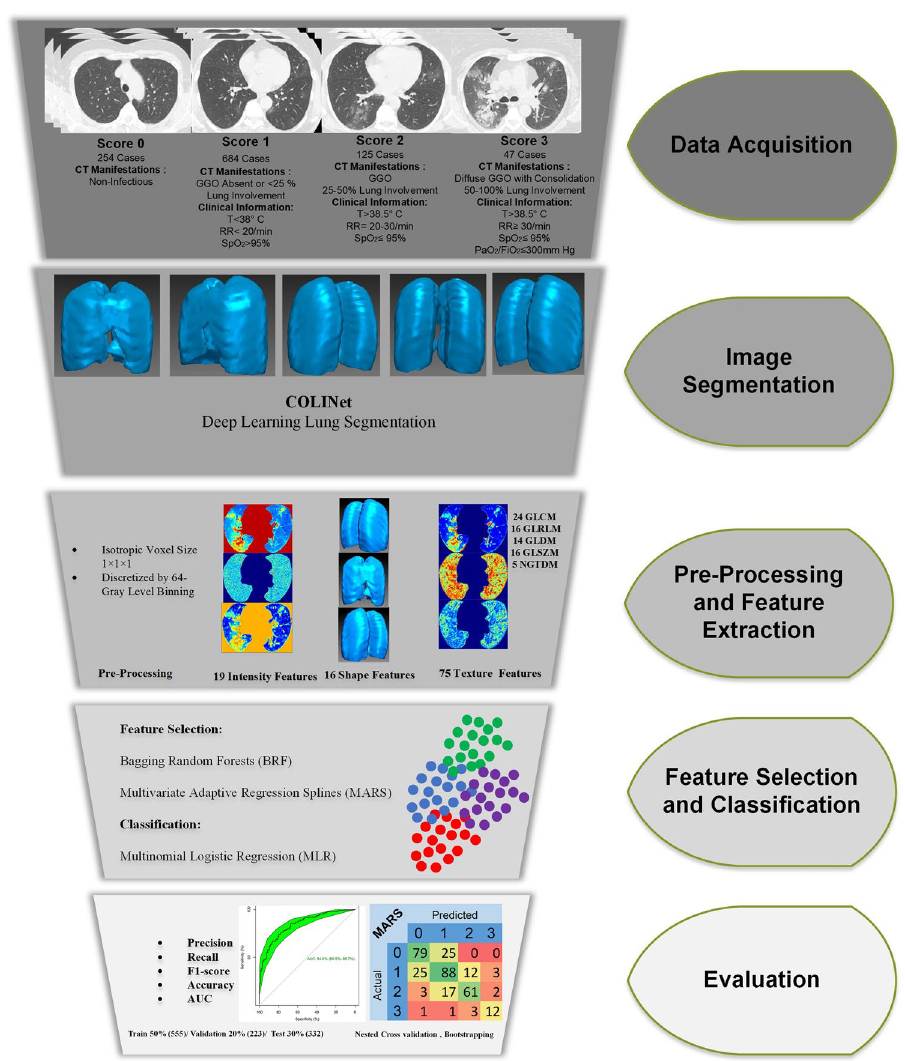
Figure 1. Different steps of the current study, including data acquisition, image segmentation using COLI- Net, image preprocessing and feature extraction, machine learning and evaluation method and metrics. GGO: ground glass opacities, T: Temperature, RR: Respiratory Rate, SpO 2 : Peripheral Capillary Oxygen Saturation, PaO 2 : Partial Pressure of Oxygen. FiO 2 = Fraction of Inspired